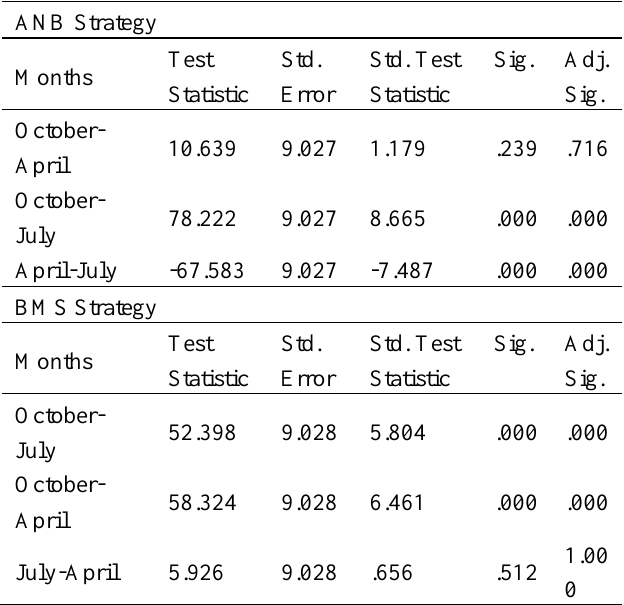
Pairwise Comparisons of illuminance based on Months for each strategy.